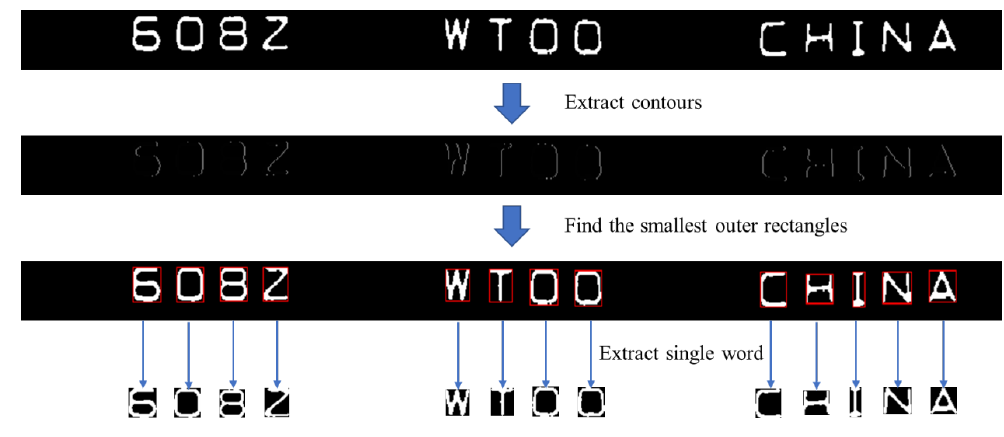
Figure 13. Character extraction